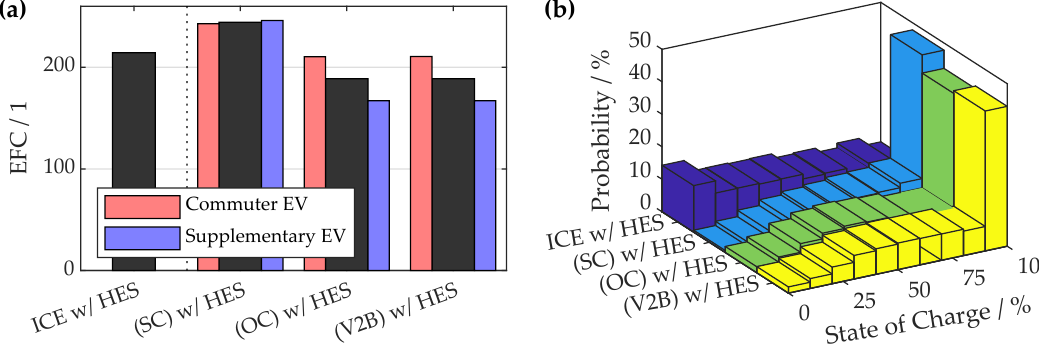
Figure 10. ( a ) Average amount of annual equivalent full cycles (EFC) of the home energy storage system and ( b ) probability distribution of the average state of charge (SOC) per scenario. The dark-grey column represents the average